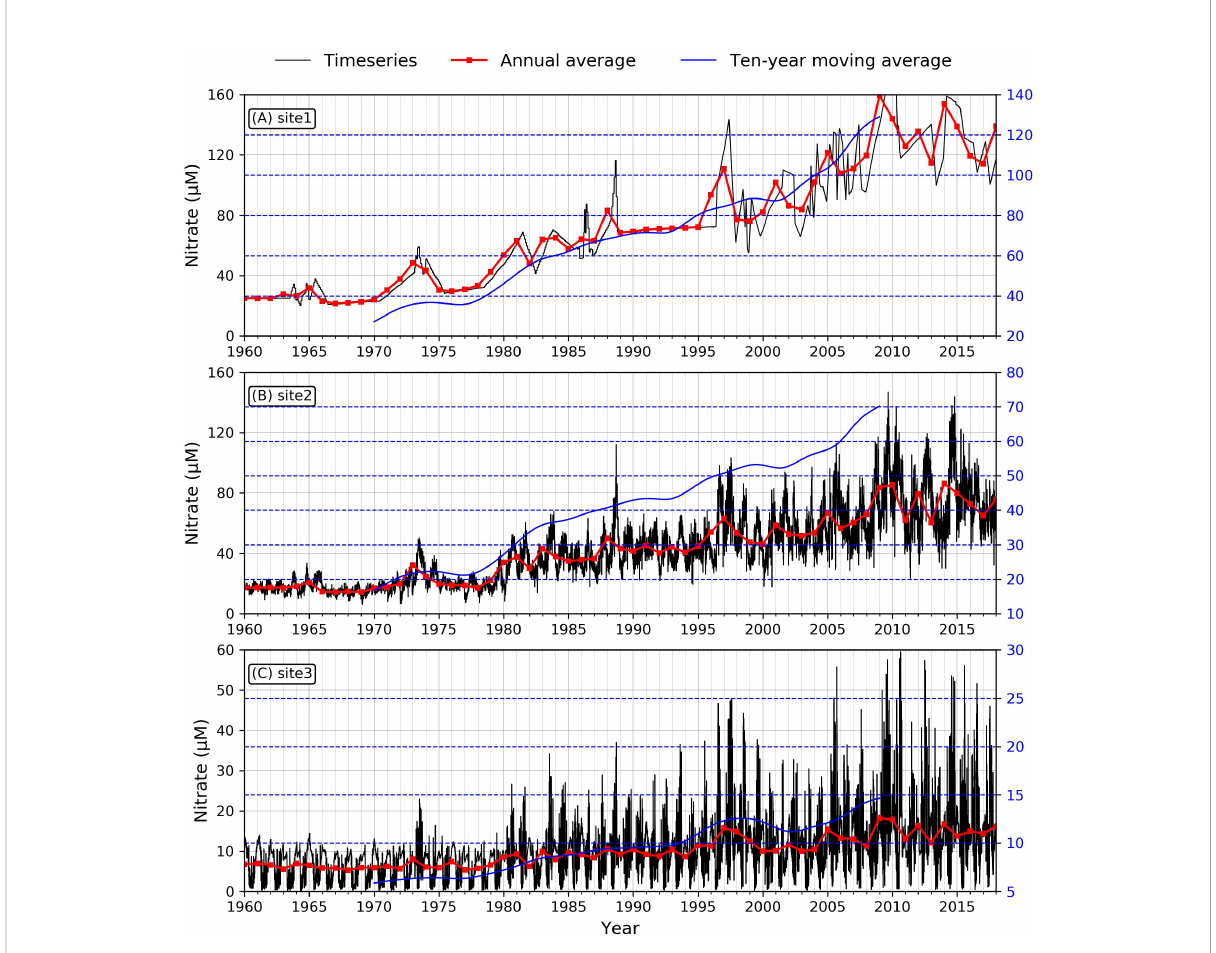
FIGURE 3 Modeled time series of nitrate concentration at the three sites. ( A : site1, B : site2, C : site3). Black lines demonstrate the daily averaged nitrate concentration, red lines are annual averaged values, and blue lines indicate ten-year moving averaged